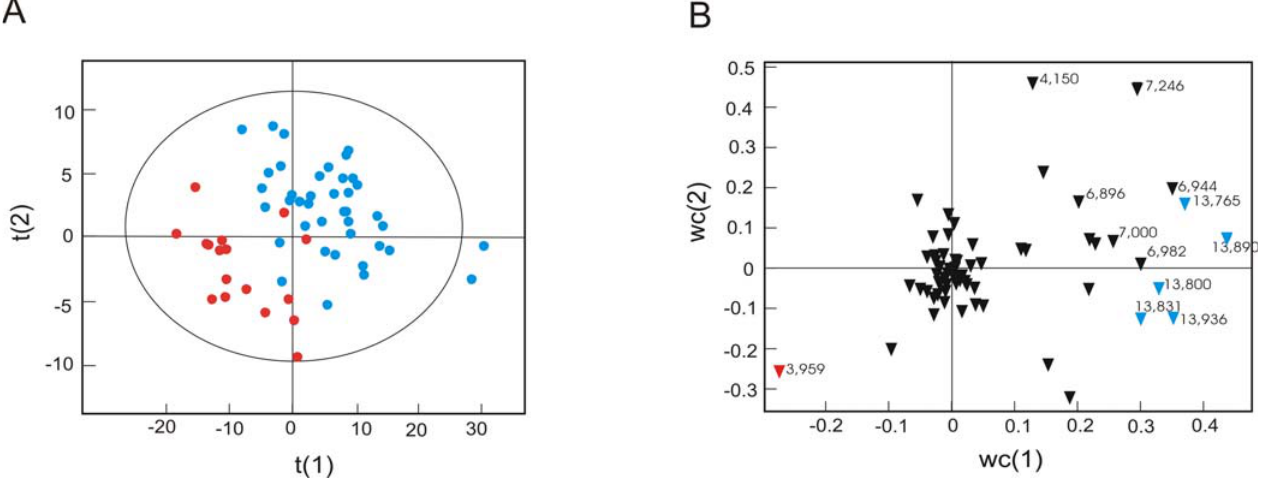
Figure 6. PLS-DA Analysis of CSF Protein/Peptide Profiles from an Independent Validation Sample Set Containing 17 First-Onset, Drug-Naı¨ve Schizophrenia Patients and 40 Healthy Volunteers The demographic details of this sample set are listed in Table 2. The PLS-DA scores plot shows a separation between patients (in red) and healthy volunteers (in blue). The loadings plot indicates similar key variables (e.g., the 3,959-Da VGF23–62 peptide [in red] and transthyretin protein signals between 13,600 and 14,000 [in blue]) identified in the first experiment (see Figure 1).